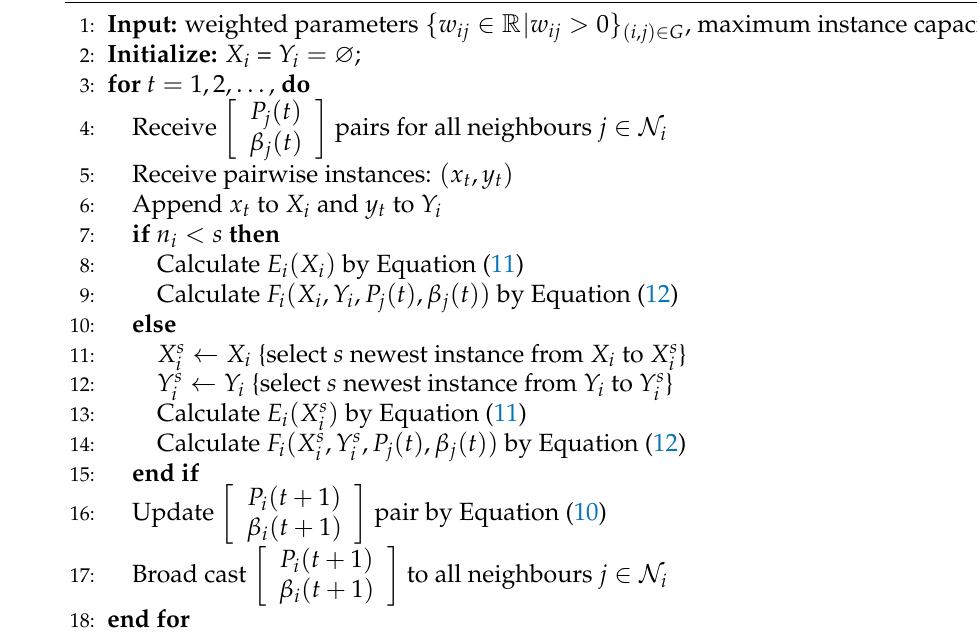
Algorithm 1 Single node update of the distributed OMLC